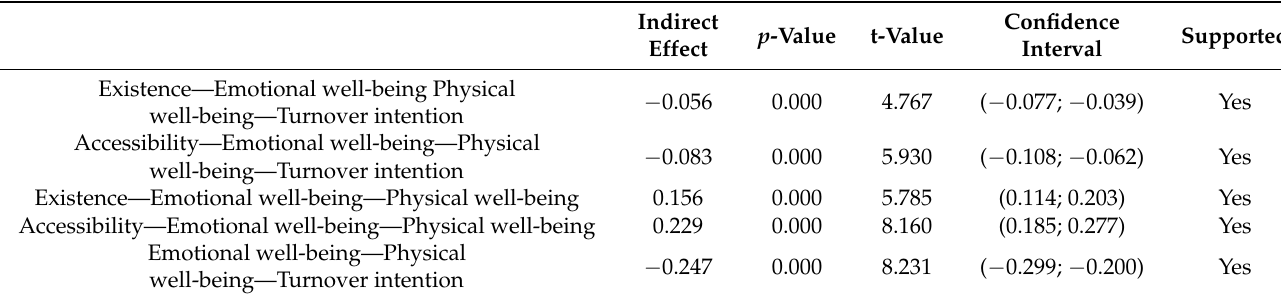
Table 4. Indirect effects. Mediation.